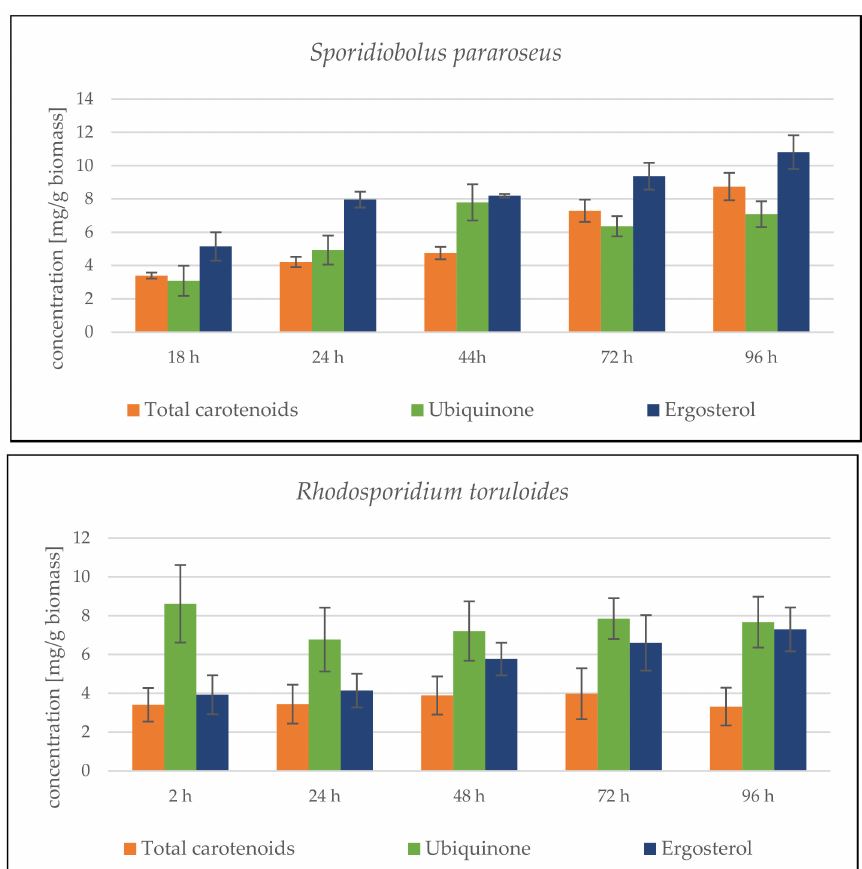
Figure 3. HPLC analysis of Sporidiobolus pararoseus and Rhodosporidium toruloides : 96 h bioreactor cultivation on SCG hydrolysate + waste animal